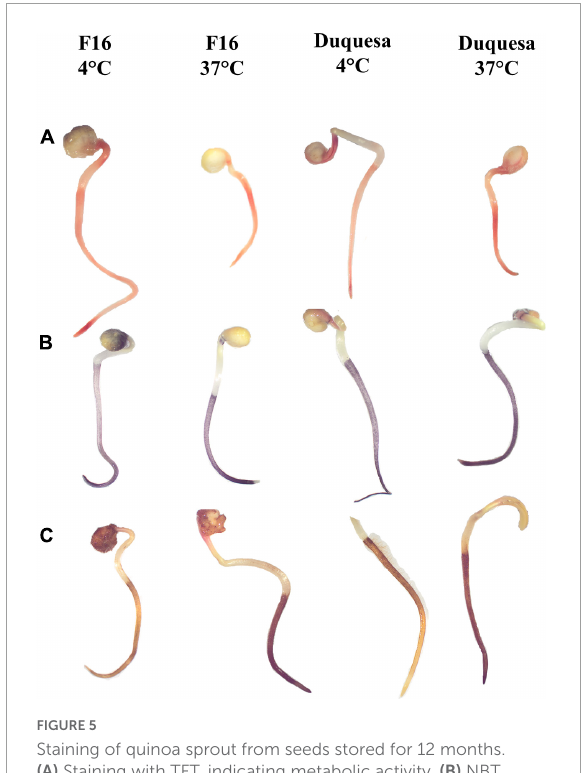
FIGURE5 Staining of quinoa sprout from seeds stored for 12 months. (A) Staining with TFT, indicating metabolic activity, (B) NBT, indicating superoxide anion accumulation, and (C) DAB, showing hydrogen peroxide accumulation, of F16 seedlings stored at 4 and 37 ◦ C and Duquesa seeds stored at 4 and 37 ◦ C, from left to right, respectively. The black bar indicates scale of 5